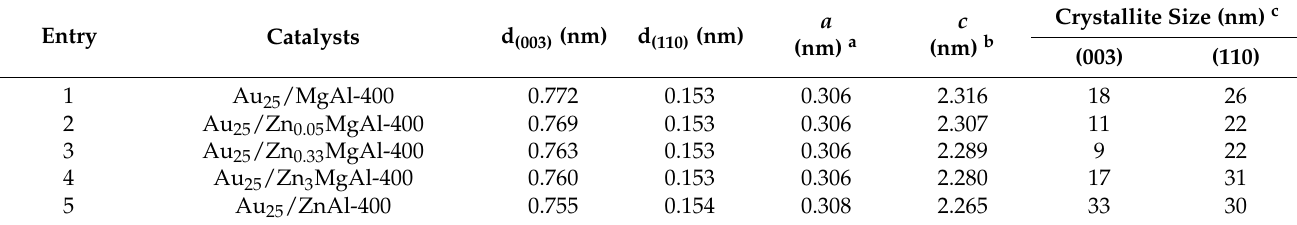
Table 2. Crystallographic parameters calculated for Zn-Mg-Al HTs supported gold nanoclusters.